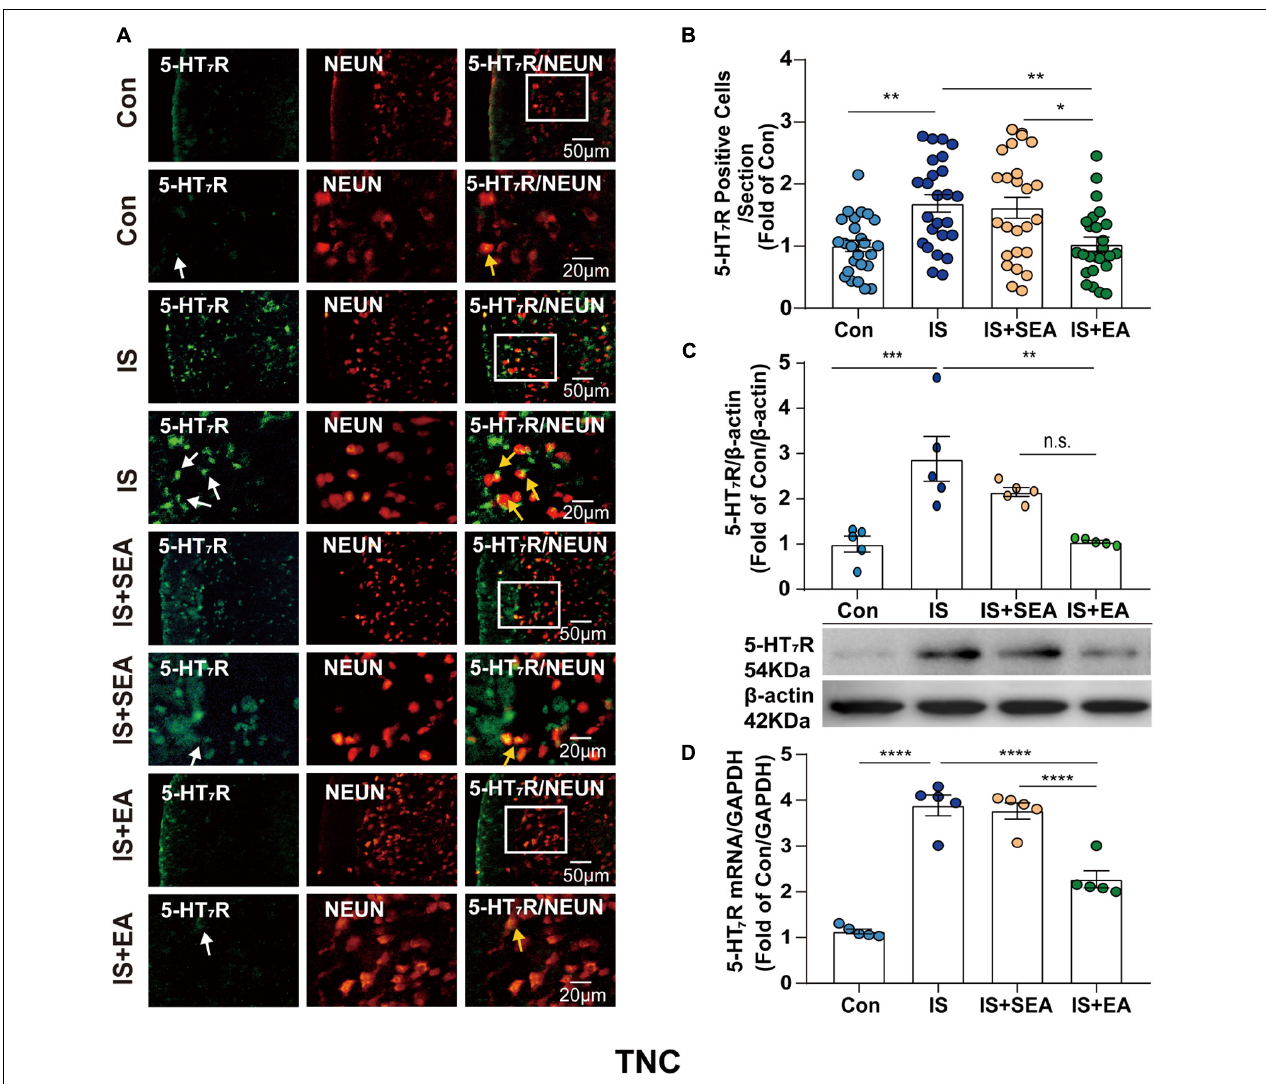
FIGURE 5 | Effects of EA on the endogenous 5-HT 7 R in the TNC on day 8 after the 4th IS injection. (A) Immunofluorescence showed that 5-HT 7 R (green) was expressed mostly in the individual neurons (NeuN, neuron marker, red) of the TNC. The upper panel displays the expression of 5-HT 7 R at low magnification, and the lower panel displays the expression of 5-HT 7 R in the TNC at high magnification in each group. The white and orange arrows point to the positive cells in TNC. Scale bars = 50 or 20 µ m. (B) Quantitative analyses of 5-HT 7 R to evaluate the numbers of positive cells ( n = 5, five sections/animal). (C) Representative western blot bands and quantitative analyses of 5-HT 7 R. The same membranes were probed for 5-HT 7 R with β -actin; ( n = 5). (D) The mRNA levels of 5-HT 7 R were also accessed by real-time polymerase chain reaction, and values were corrected by GAPDH in TNC ( n = 5). One-way ANOVA followed by post hoc Tukey test. Group values are indicated by mean ± SEM. * P < 0.05, ** P < 0.01, *** P < 0.001, **** P < 0.0001. 5-HT 7 R, 5-hydroxytryptamine (5-HT) 7 receptor; TNC, trigeminal nucleus caudalis; EA, electroacupuncture; IS, inflammatory soup; SEA, sham electroacupuncture; Con,